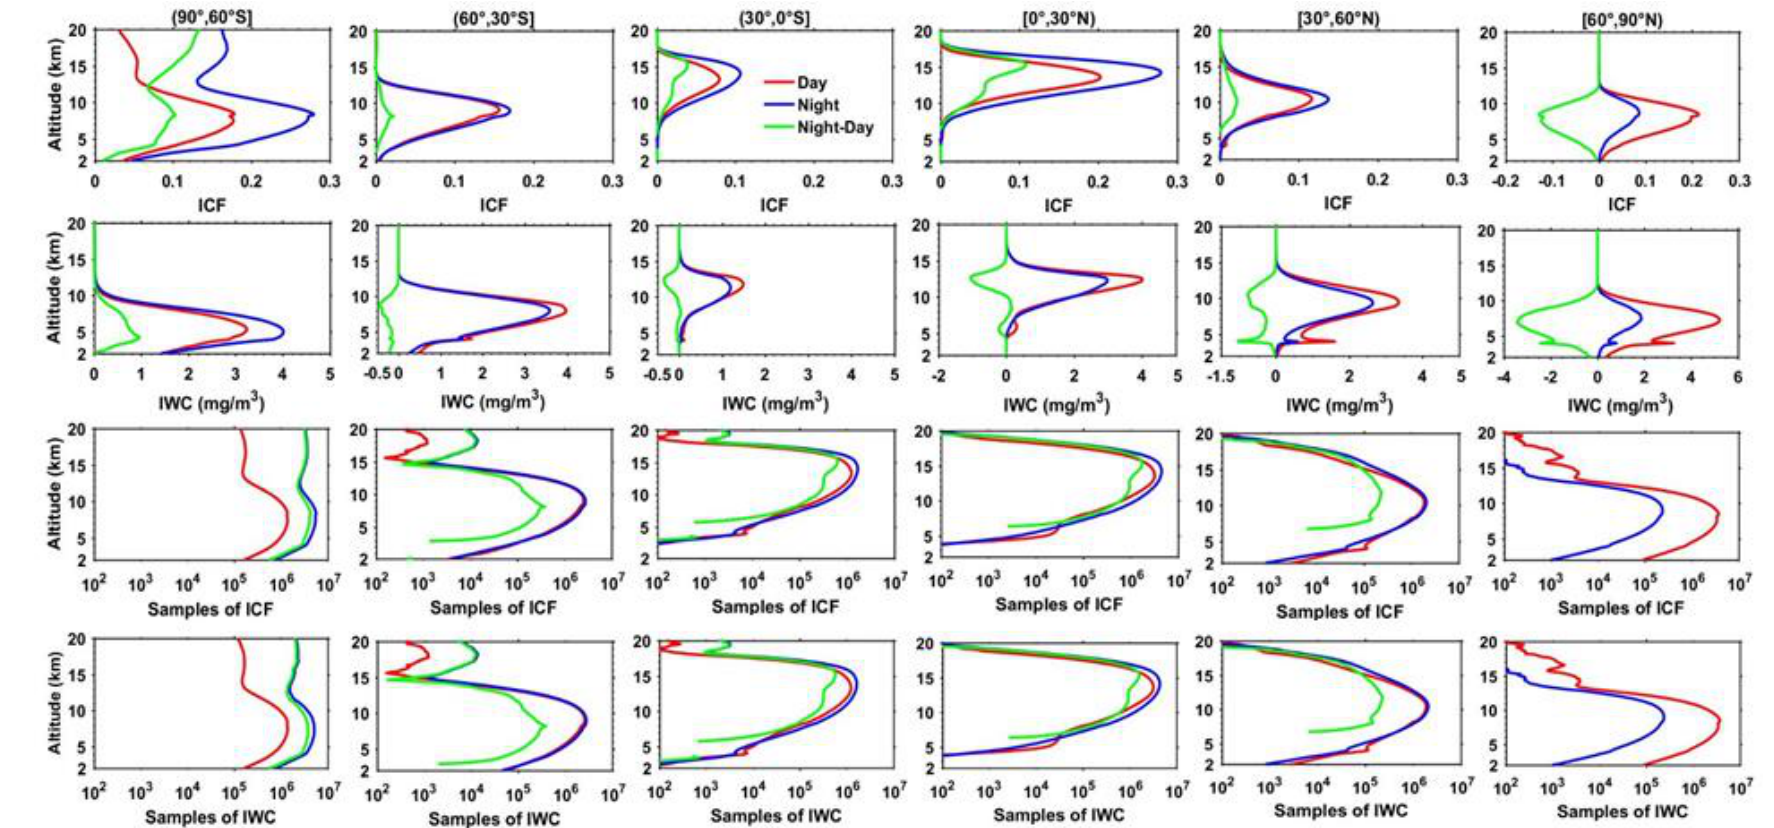
Figure 4. Diurnal variations (night-minus-day measurements) of zonal mean profiles of the frequency of occurrences of ICF and IWC (the first and second rows), vertical patterns of a 10-year total number of ICF and IWC samples (the third and fourth rows).